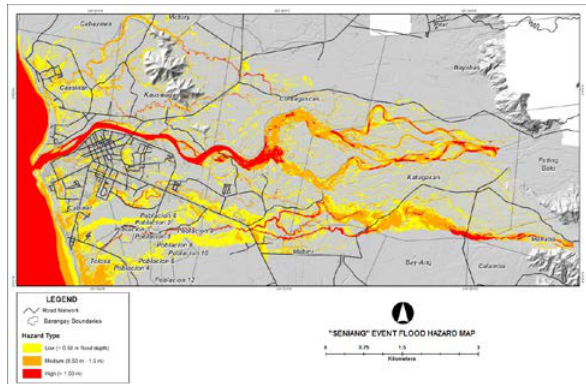
Figure 6. Map of flood hazard based on maximum flood depths.